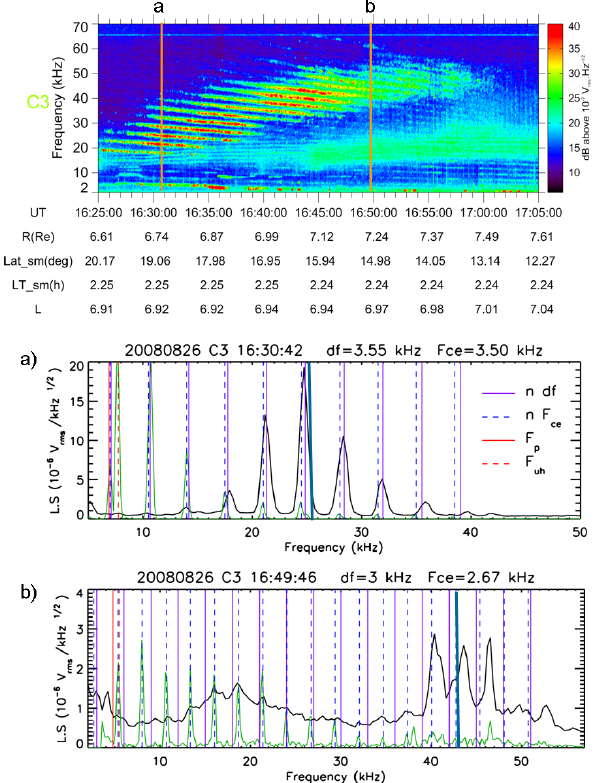
Figure 6. Spectral characteristics of the electric field measured by the C3 during the 26 August 2008 event. Top: time–frequency spectrogram from 16:25 to 17:05UT, orange lines indicate selected times of the spectra shown below. Bottom: individual spectra for the two selected times ( a 16:30:42UT, b 16:49:46UT) (presentation as in Fig. 5). Sounding spectra have electric field magnitudes divided by a factor of 50 and 10, respectively. Figure 7. Frequency spectrum of the electric field measured by the C1 Cluster satellite during the 26 August 2008 event, at 16:36:01UT (presentation as in Figs. 5 and